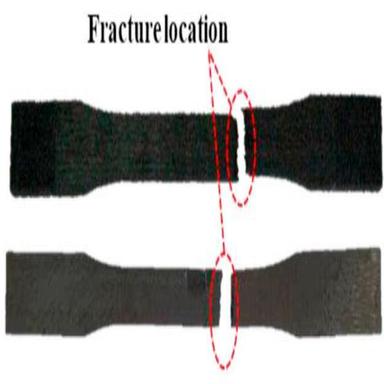
Comparison of fracture locations from the simulation and the experiment.